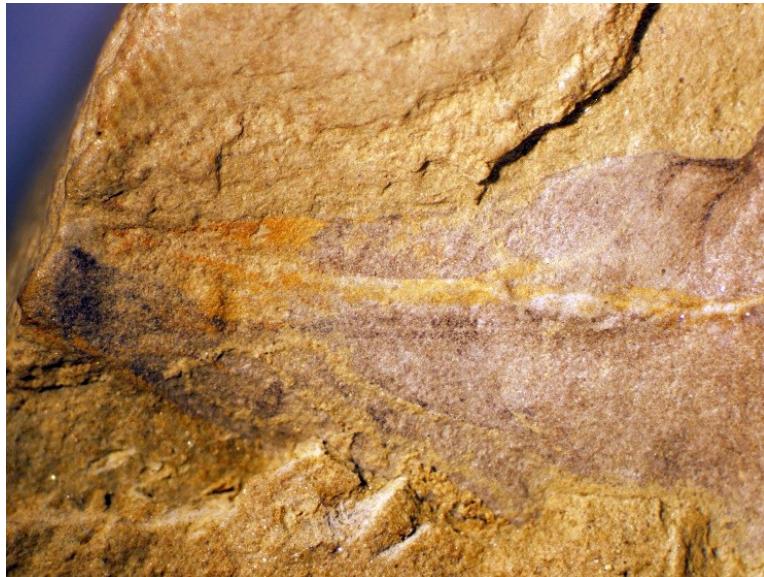
Figure 22. Shenzianyuloma yunnanense nov. gen. nov. sp. IGM 5008. Detail showing notochord and posterior gut trace. Myomeres are visible in both the dorsal and ventral portions of the tail. Photo Credit: Mark McMenamin.